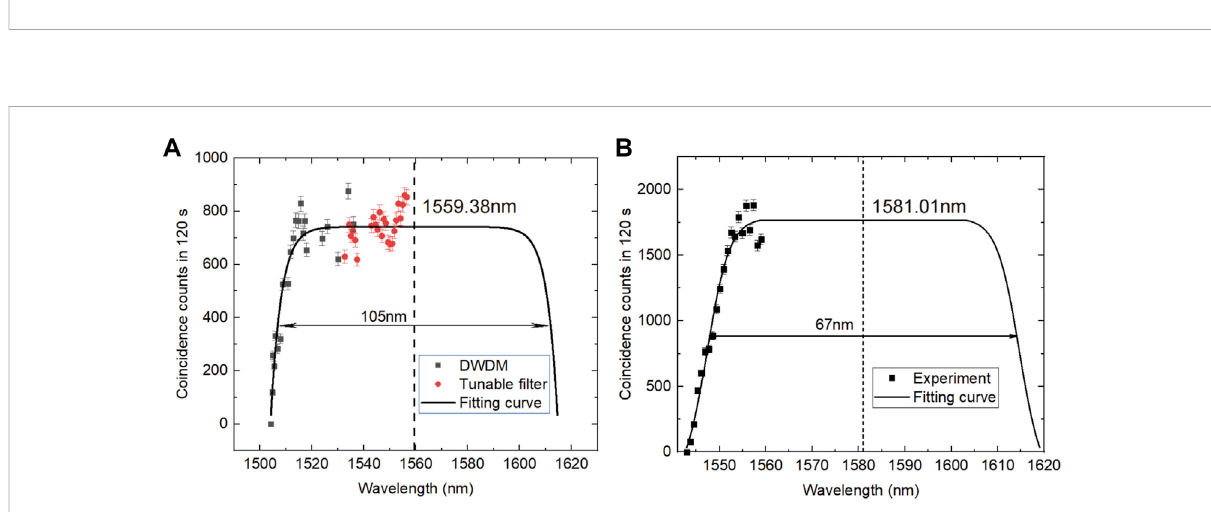
FIGURE 6 Experimental and simulated spectral brightness of the broadband type- Ⅱ (A) and type-0 (B) SPDC.